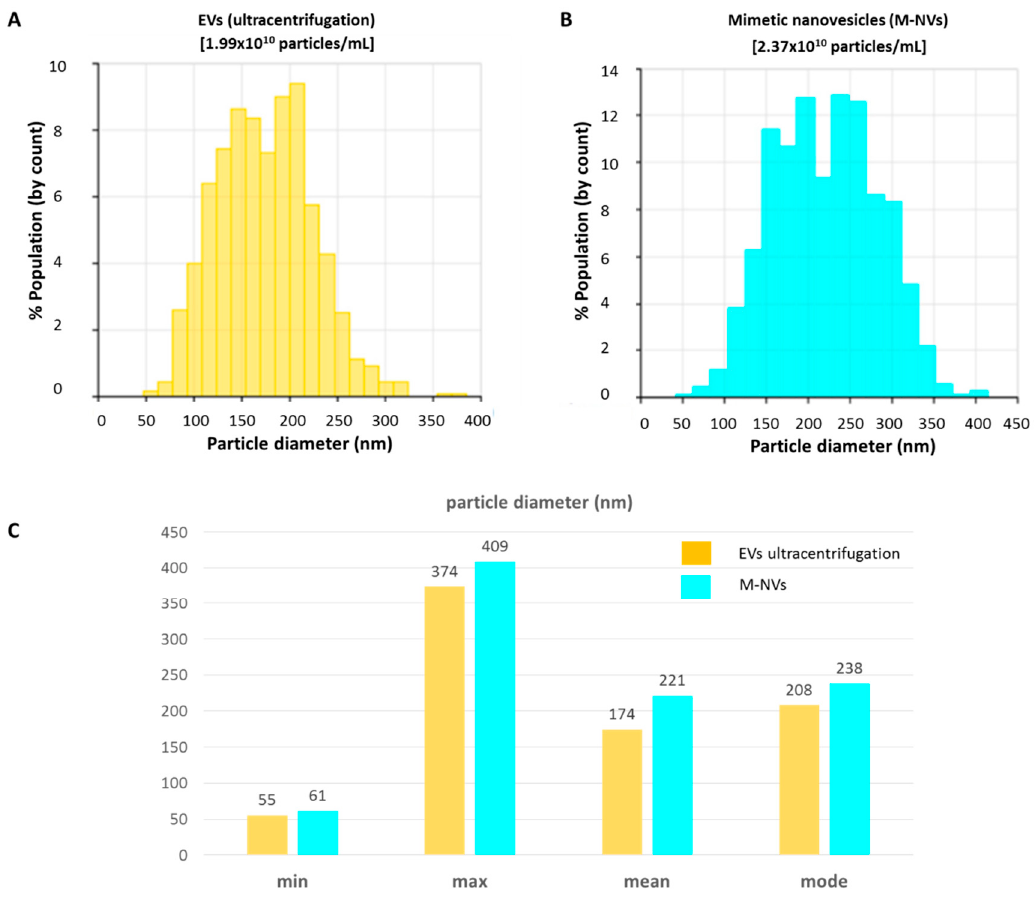
Figure 1. Analysis of T98G-derived EVs size and concentration. ( A ) EVs isolated by ultracentrifugation and ( B ) by plasma membranes reassembling protocol (M-NVs) were analysed through TRPS (qNano Gold, Izon). ( C ) Histogram of size distribution values of minimum, maximum, mean and mode values of the analysed nanoparticles ( n = 2000).